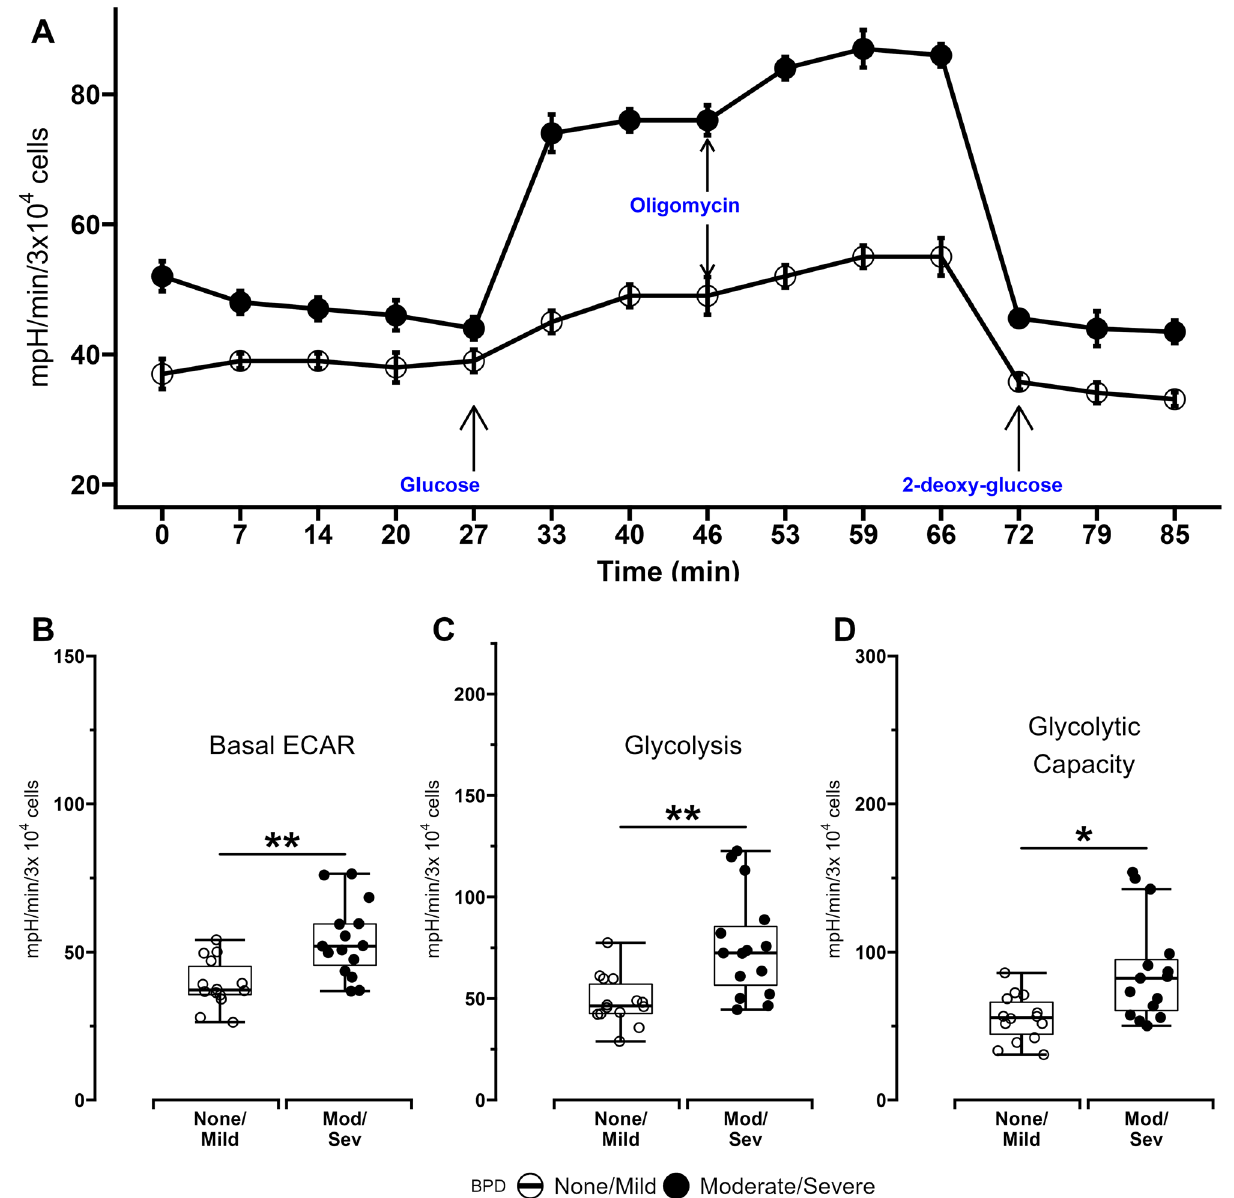
( A ) Representative plot of a typical glycolytic stress test conducted using a Seahorse XF96 flux analyzer. 30,000 cells were seeded per well in 96-well plates, and MSC extracellular acidification was measured in the presence of various glycolytic effectors. ( B ) Basal ECAR. ( C ) ECAR during glycolysis ( D ) ECAR due to maximal glycolysis measured after oligomycin introduction. Data for all experiments obtained from MSCs from 15 infants with Mod/Sev BPD and 14 with No/Mild BPD. Differences were analyzed using Mann–Whitney U-test and data expressed as median [25th–75th centiles]. * and ** represent p value < 0.05 and < 0.005 respectively. NS —no significant